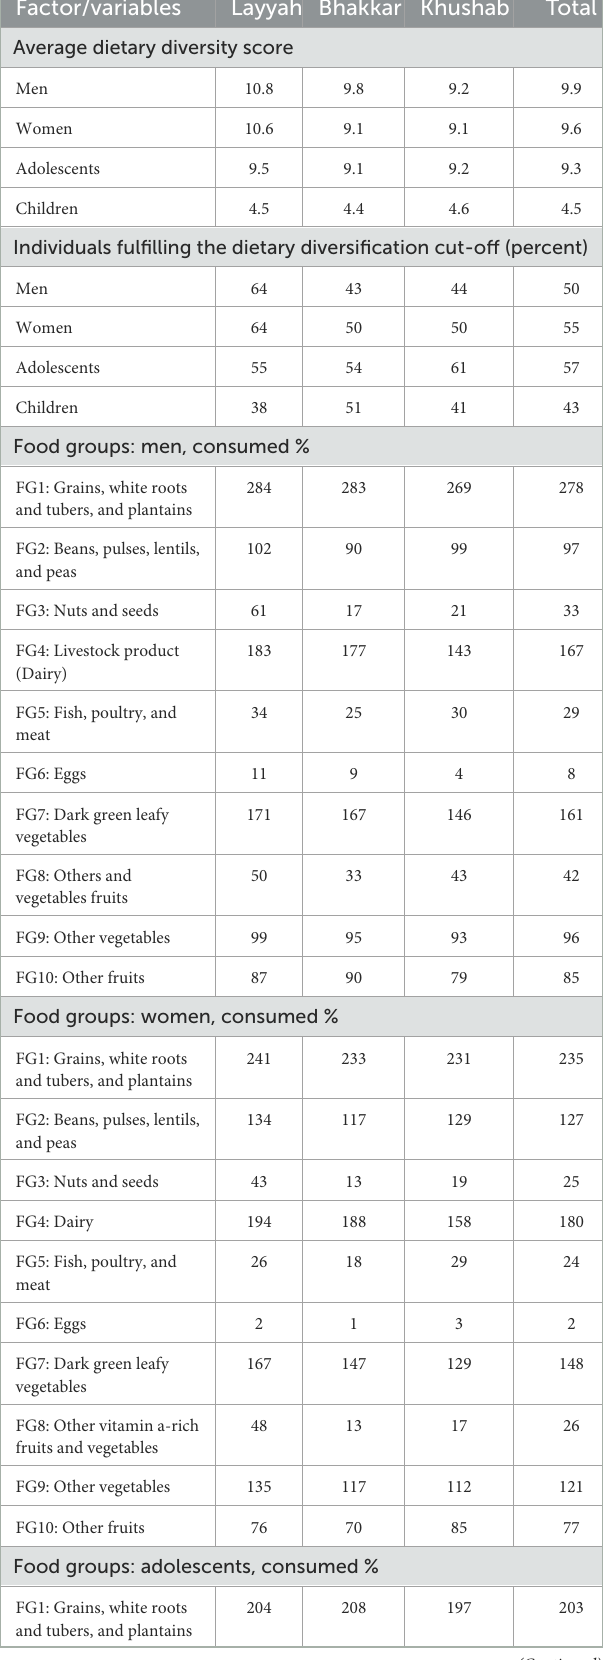
TABLE 1 Results of average (DDS), across farmer households in Layyah, Bhakkar, and Khushab (24-h recall) in percentage.